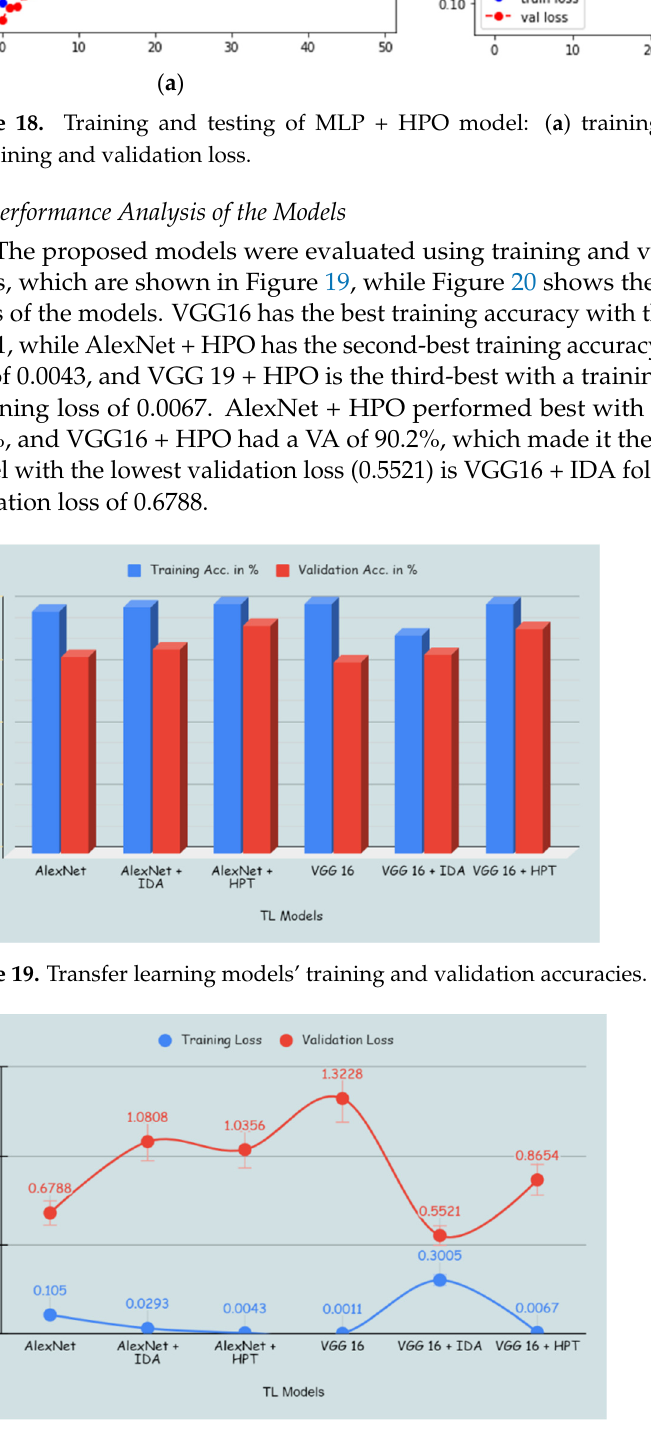
Figure 20. Transfer learning models’ training and validation losses.